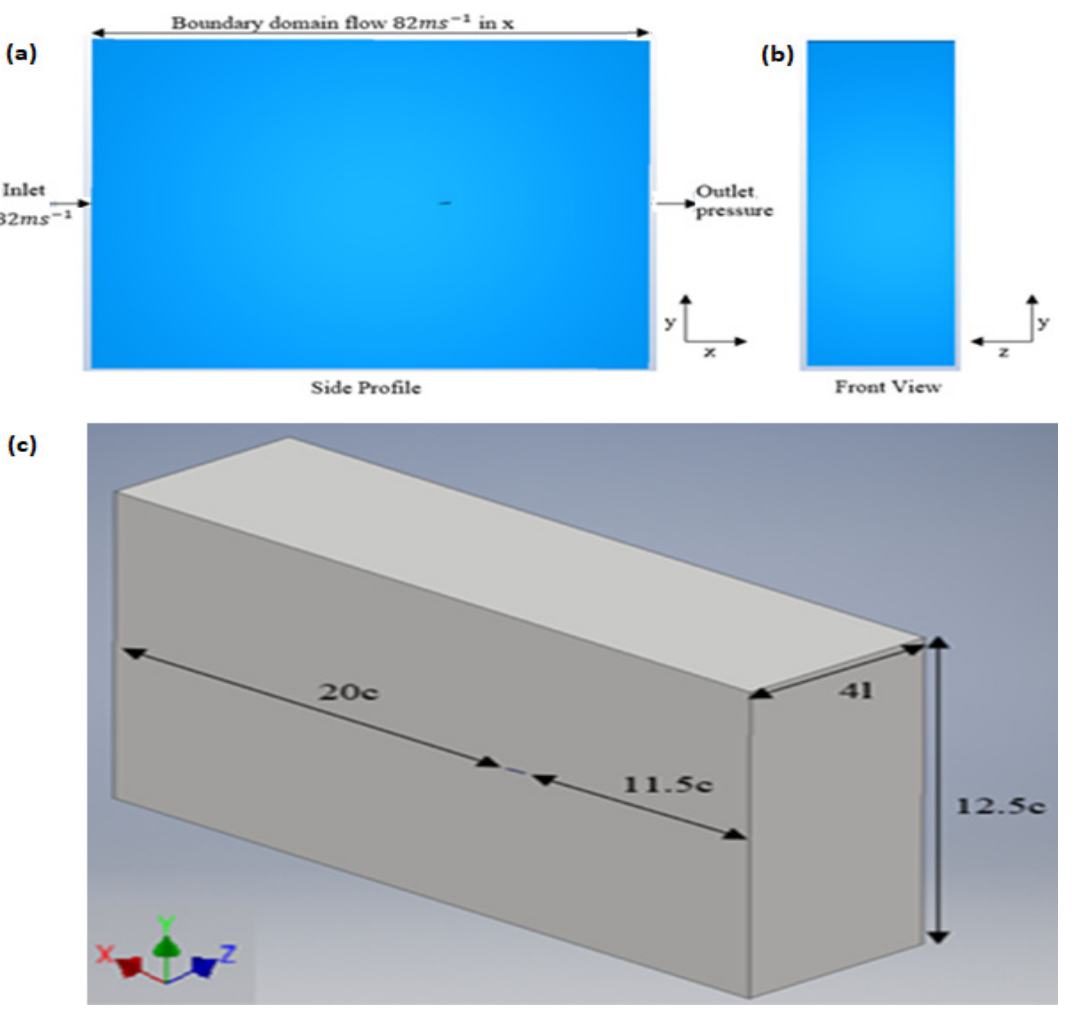
Figure 5. Boundary domain flow of the enclosure for the winglet in 3D, showing ( a ) side, ( b ) front, and ( c ) isometric views.